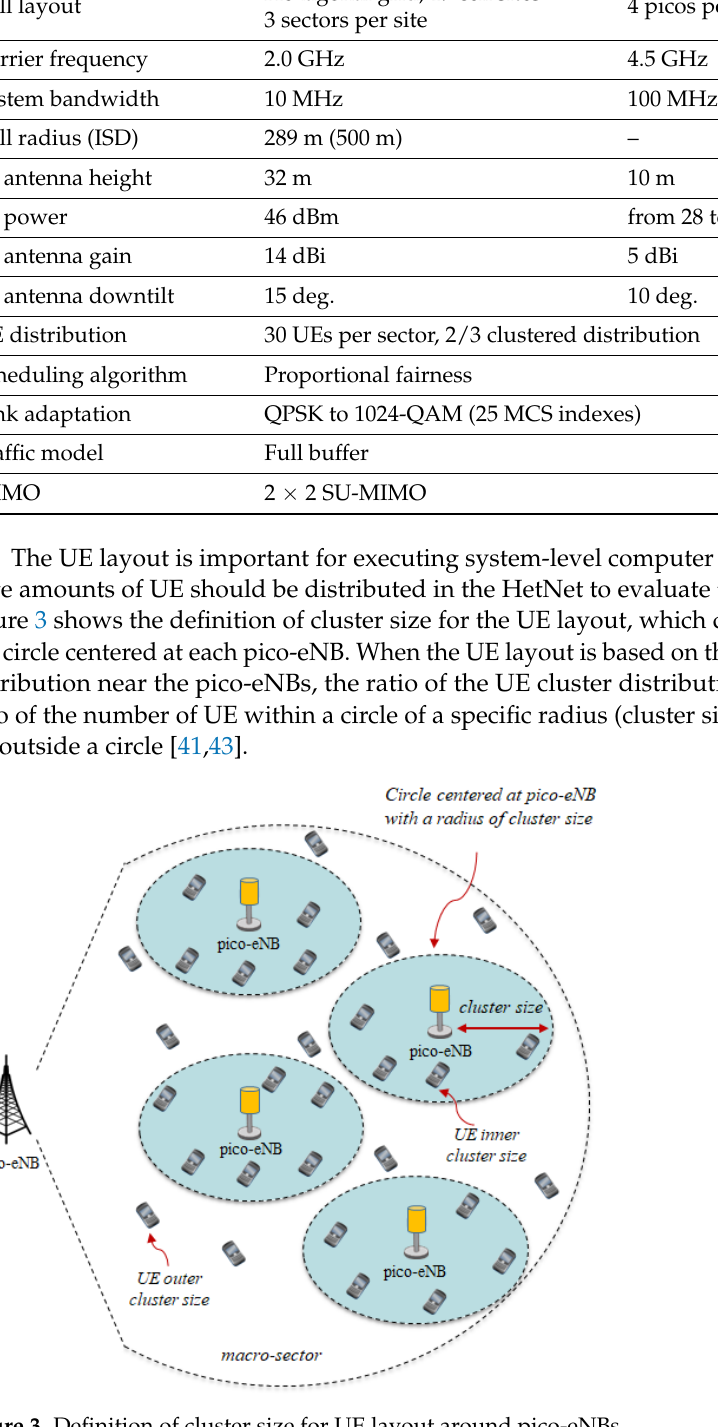
Figure 3. Definition of cluster size for UE layout around pico-eNBs.